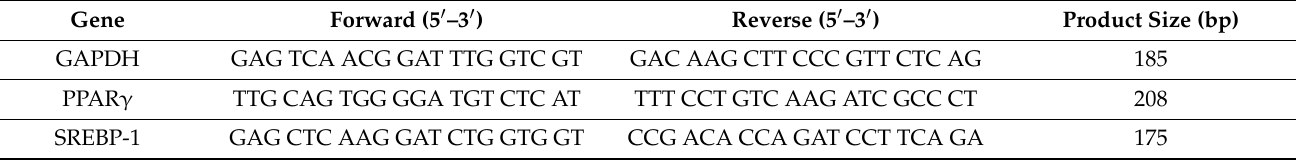
Table 1. Primers used for the quantitative PCR